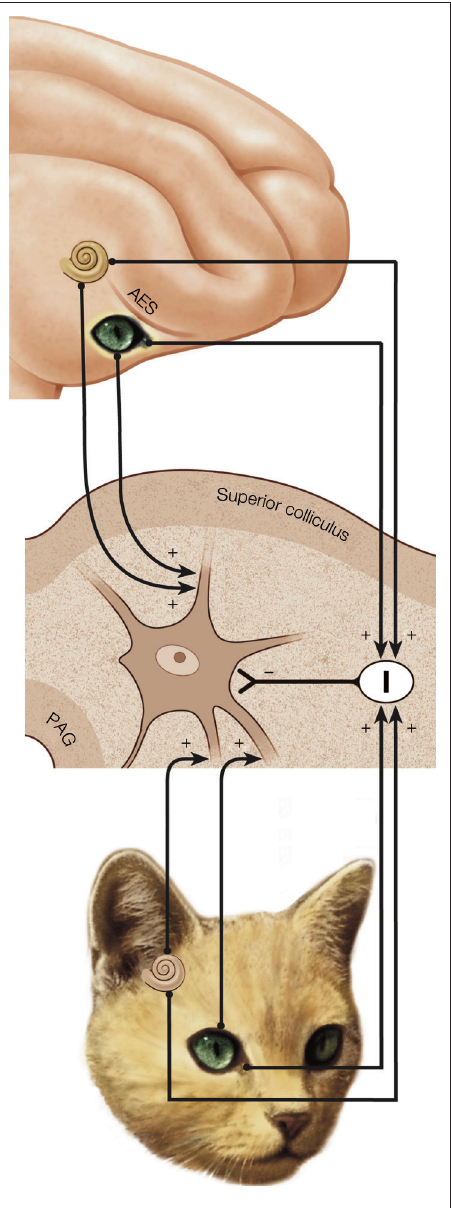
Figure 1 | A schematic model of the circuit believed to support multisensory integration in the superior colliculus (SC). A multisensory (visual-auditory) neuron receives input from a number of unisensory sources; in particular, inputs derived from areas of association cortex (e.g., AES) (top) and inputs from other sources (bottom). These inputs also project to an inhibitory interneuron population (I). The inhibitory connections “offset,” or balance, the excitatory inputs, but have a greater impact on non-AES than AES inputs. The balance of excitation and inhibition in this single-unit model replicates a number of physiological findings pertaining to multisensory integration in the SC; for example, its dependence on the functional integrity of cortico-collicular afferents from AES. The nature of the biophysical mechanisms underlying multisensory integration remains an active area of empirical